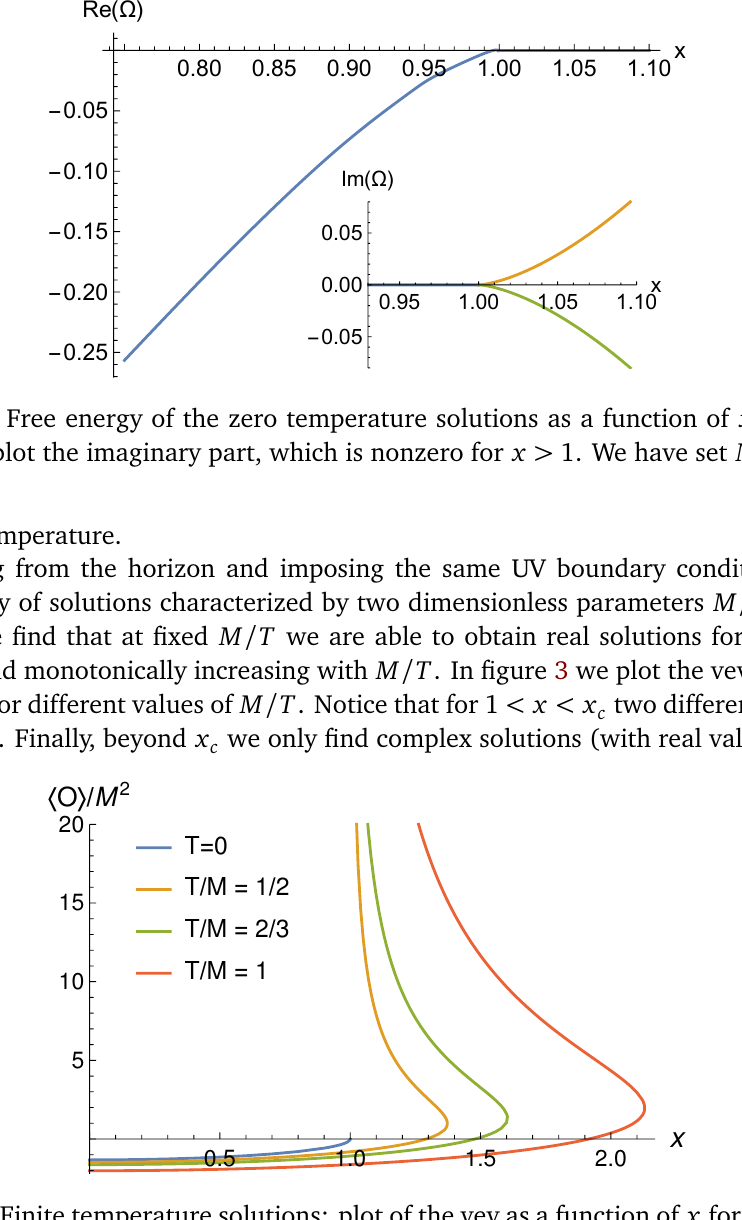
Figure 3: Finite temperature solutions: plot of the vev as a function of x for different values of T / M . The T = 0 result is included for